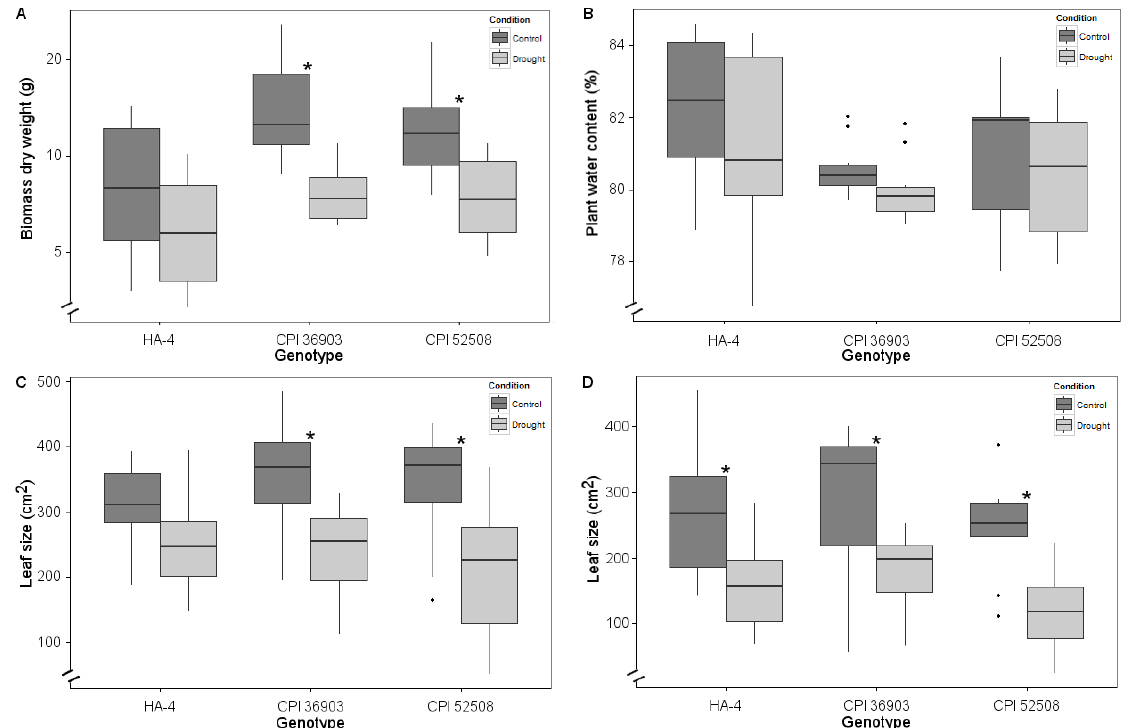
Fig. 1: Effects of water limitation after 15 days on (A) biomass dry weight (g), (B) plant water content (%) and after eight days on (C) size older leaf (cm 2 ) and (D) size younger leaf (cm 2 ); n=10, genotypes with * = p <0.05, exp.